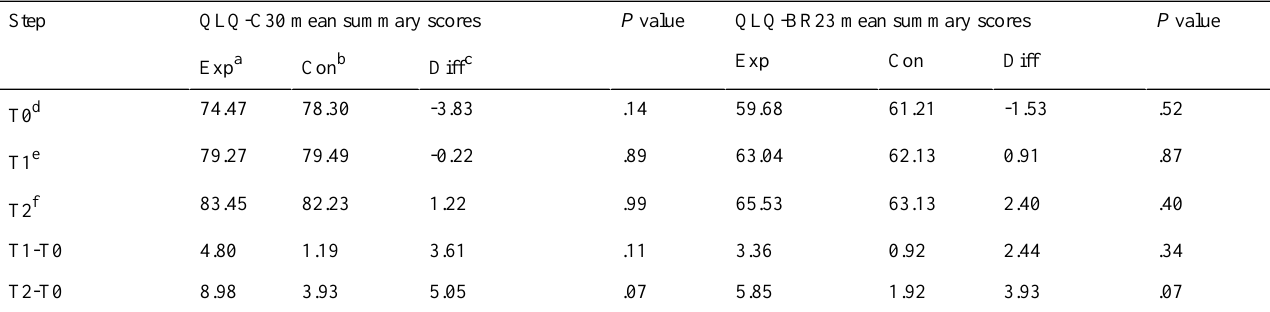
Table 5. Generalized estimating equation analysis of longitudinal outcome for the Quality-of-Life Questionnaire Core 30 (QLQ-C30) and the Breast Cancer-Specific Quality-of-Life Questionnaire (QLQ-BR23) for sensitivity